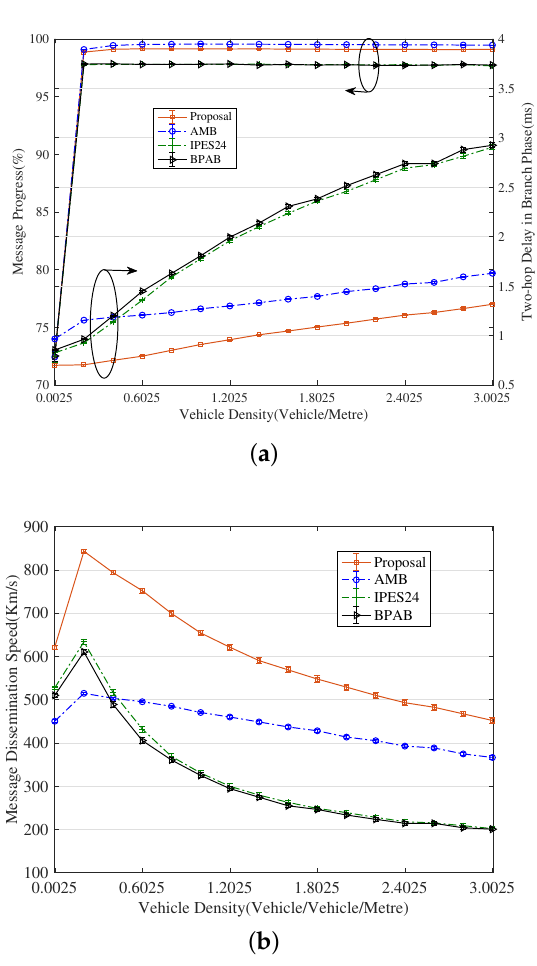
Figure 11. Comparison of efficient performance in whole procedure. ( a ) Comparison of two-hop delay and message progress; ( b ) Comparison of dissemination